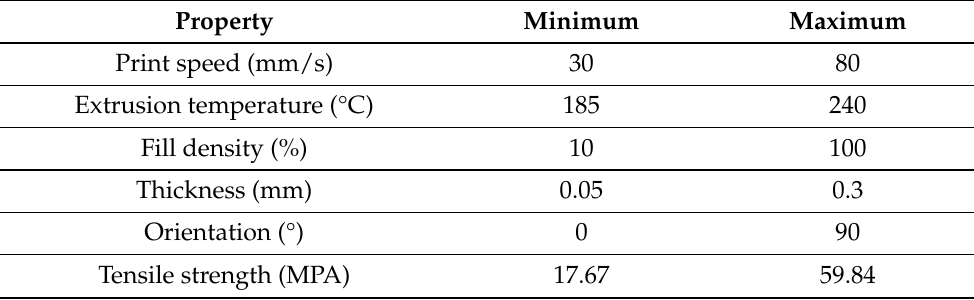
Table 2. Range of values of the properties used.